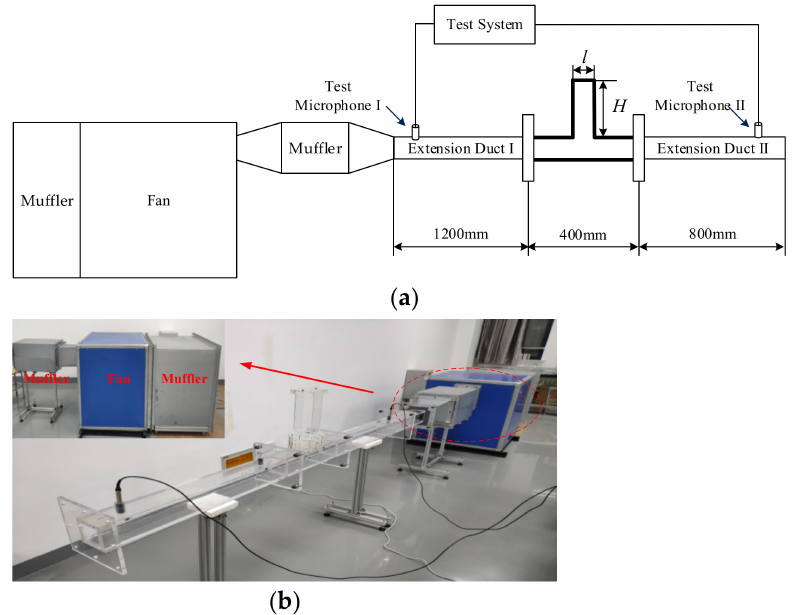
Figure 3. The experimental system: ( a ) the schematic diagram; ( b ) the experimental setup.